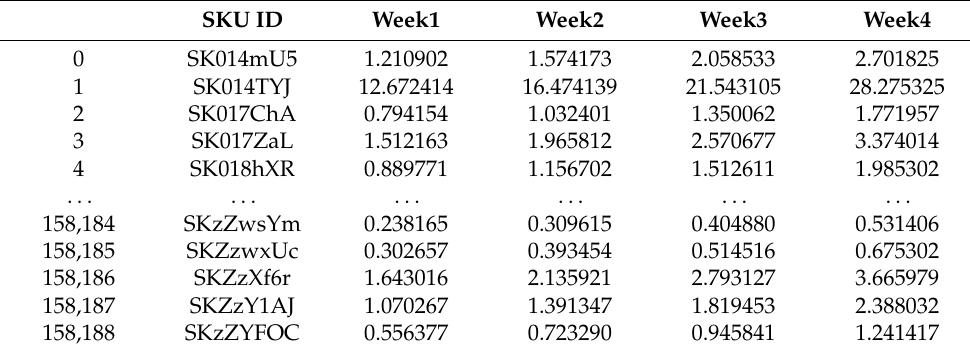
Table 3. Inventory forecasting results over four weeks.